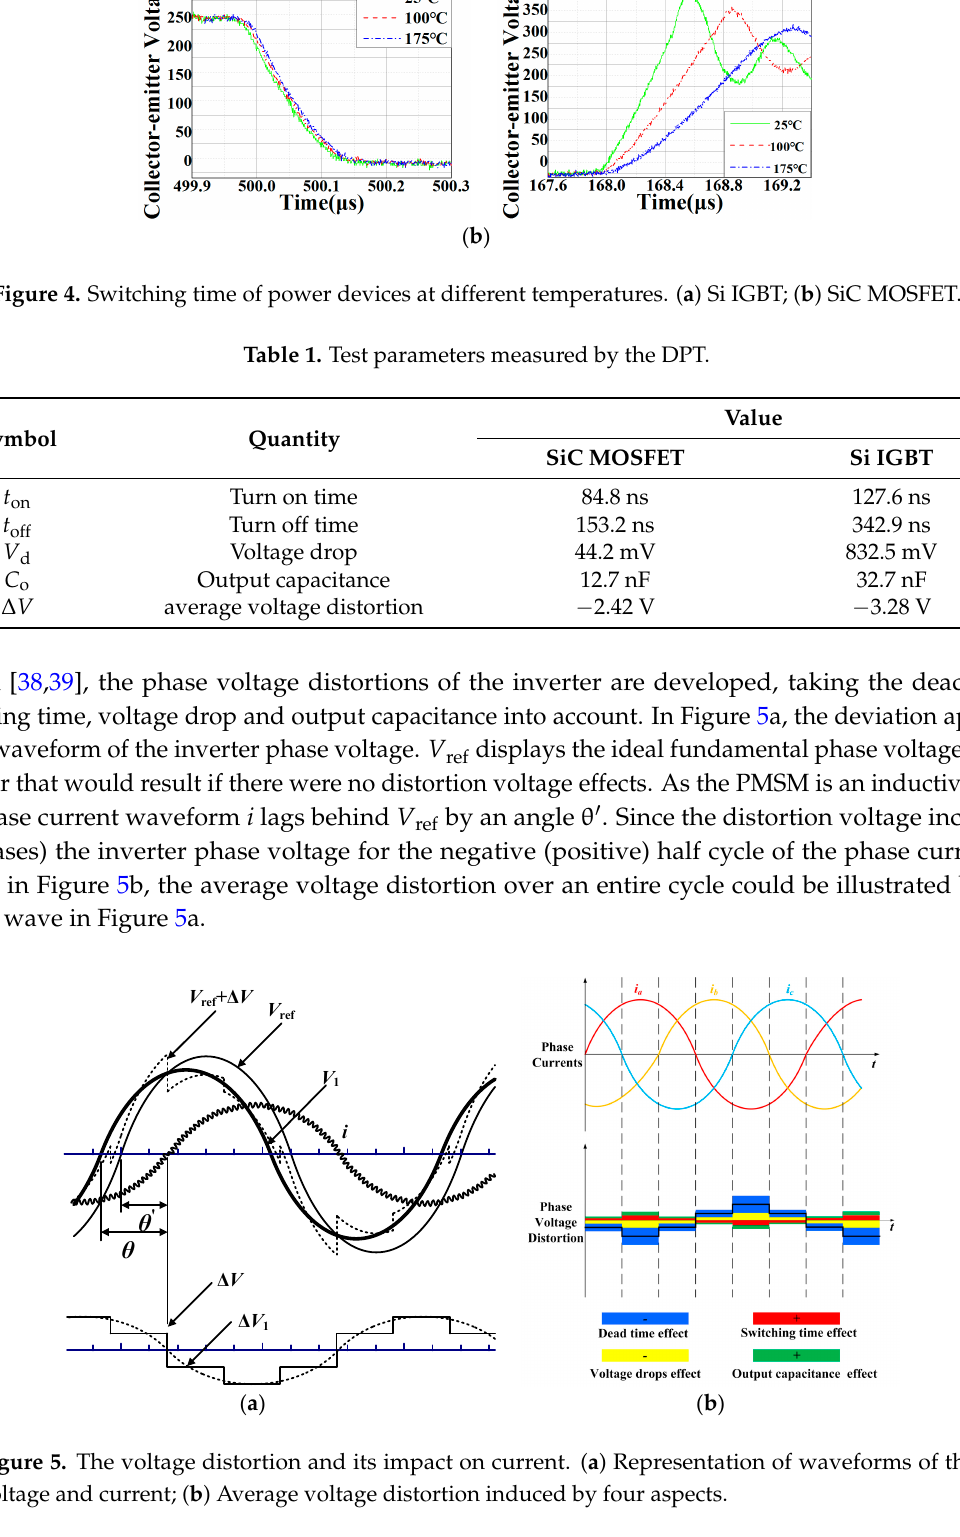
Figure 5. The voltage distortion and its impact on current. ( a ) Representation of waveforms of the voltage and current; ( b ) Average voltage distortion induced by four aspects. voltage and current; ( b ) Average voltage distortion induced by four